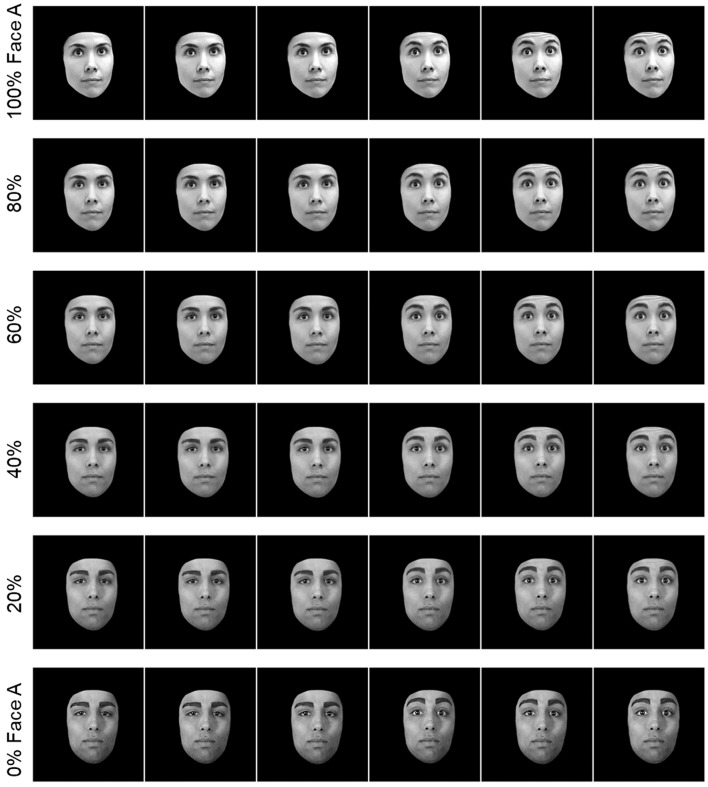
The image above shows partial image sequences from six different videos stimuli. The top and bottom videos show two different individuals making the same motion (eyebrow raise). These videos were then morphed together to create four new videos which vary on a continuum from person A to person B.